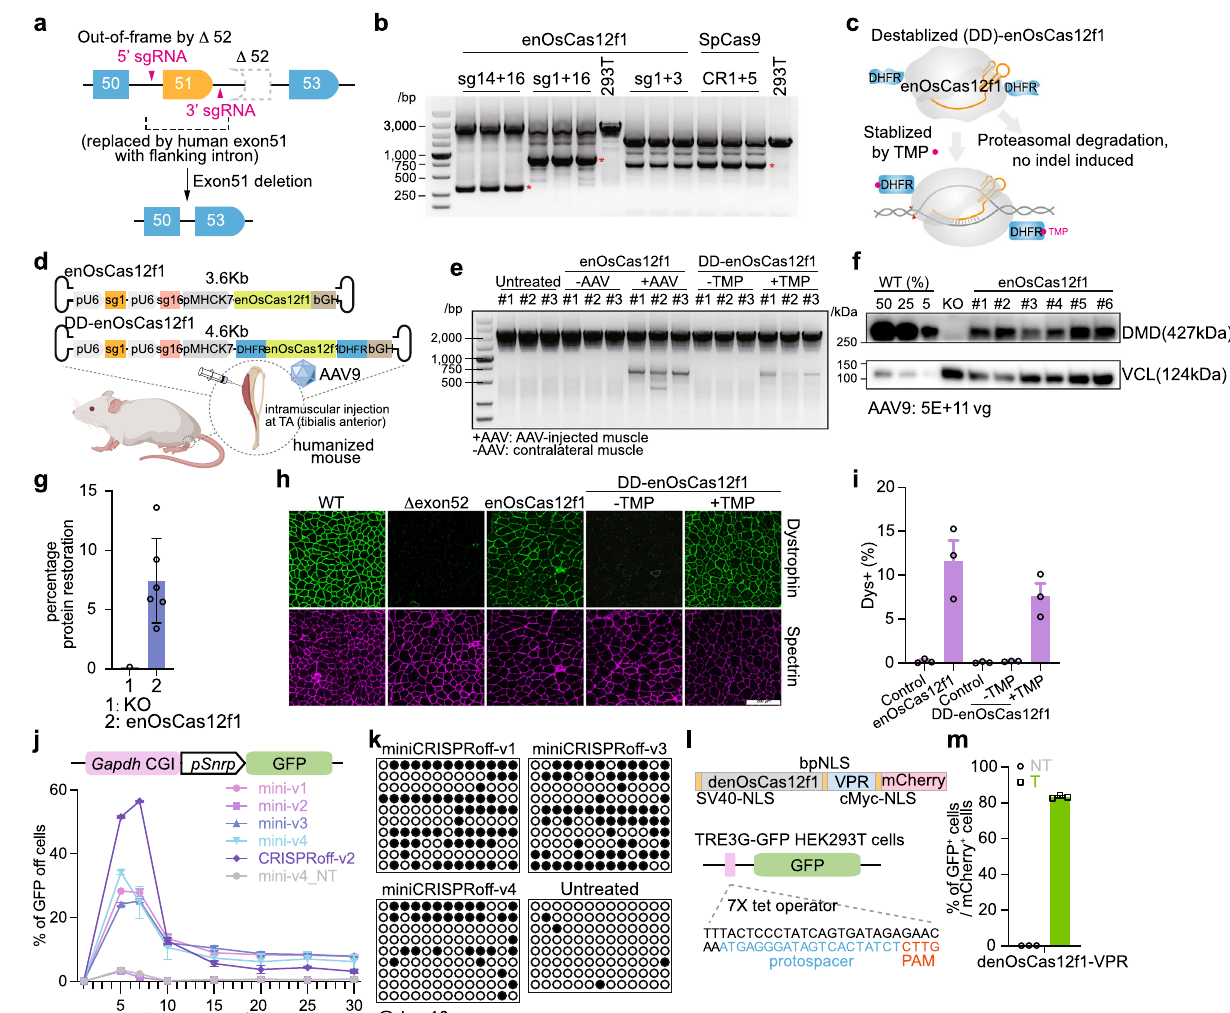
Fig. 6 | Tunable enOsCas12f1-mediated in vitro and in vivo deletion of human DMD exon 51 and engineering enOsCas12f1 for epigenome editing and gene activation. a Strategy for generating humanized DMD mutation mouse with human exon 51 replacement and exon 52 deletion. By deleting exon 51 can restore thedystrophinexpression.TwosgRNAsthatlocatedbefore(5 ’ sgRNA)andafter(3 ’ sgRNA) exon 51 are designed to delete exon 51. b enOsCas12f1- and SpCas9- mediateddeletionofDMDexon51bypairedsgRNAsinHEK293Tcells.Theexon51 deleted bands were marked by red asterisk. This experiment was repeated two times showing similar results. c Scheme representing the strategy for destabilized enOsCas12f1 (DD-enOsCas12f1). d Overview of intramuscular injection of single AAV9systeminhumanizedmouse. e Theinvivoeditingef fi cienciesofenOsCas12f1 and DD-enOsCas12f1 were tested by genomic PCR. This experiment was repeated two times showing similar results. f Western blotting for detecting recovery of dystrophin (DMD) by enOsCas12f1 and DD-enOsCas12f1 in DMD model mouses.